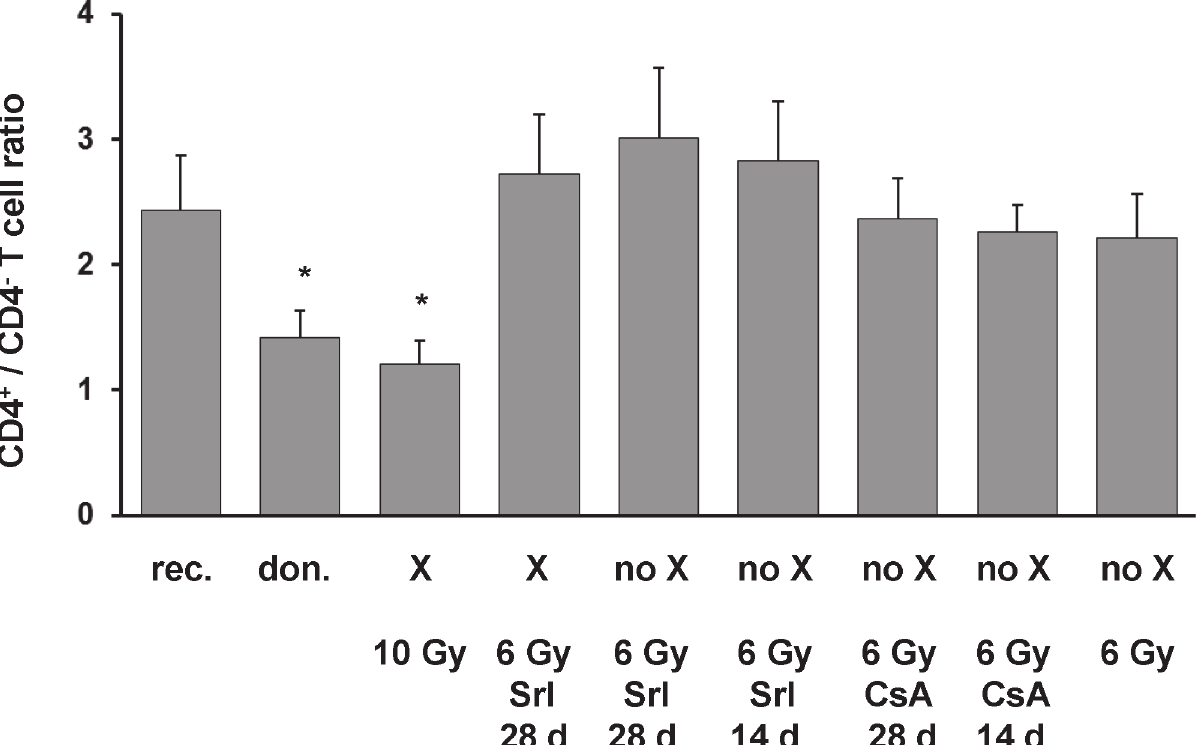
Fig 4. CD4 + /CD4 - T cell ratio in peripheral blood of T cell regenerated BMT recipients at day 100. Peripheral blood of T cell regenerated BMT recipients at day 100 was analyzed by flow cytometry (n = 5 per group). Na ï ve rats of LEW.1AR1 donor and LEW.1AR2 recipient strain with same gender and similar age were analyzed as controls (n = 5 per group). Anti- α / β TCR mAb and anti-CD4 mAb were used. Mean values of CD4 + /CD4 - ratios in α / β TCR + cells are given. The type of chimerism is indicated (X = stable chimerism, no X = no persistent chimerism). Irradiation dosages and immunosuppressants (sirolimus: Srl; cyclosporine: CsA) including duration of application in days are given. The statistical significance was appointed at * p < 0.05 for na ï ve LEW.1AR1 as well as X 10 Gy group versus na ï ve LEW.1AR2 and all other